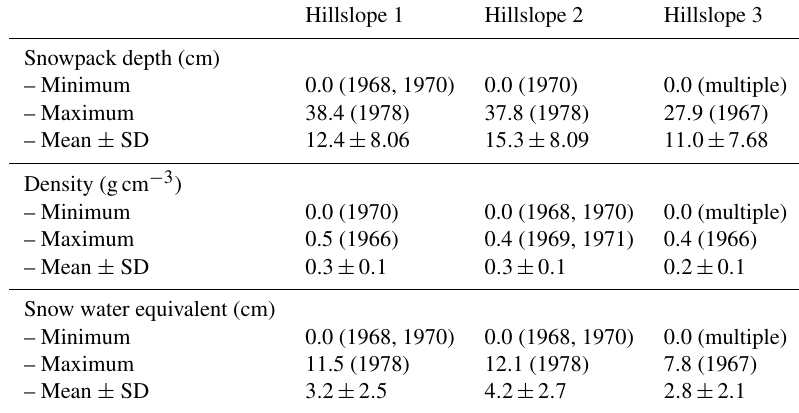
Table 5. Summary statistics of hillslope-averaged snowpack data (only using data from the last survey before the end of winter).